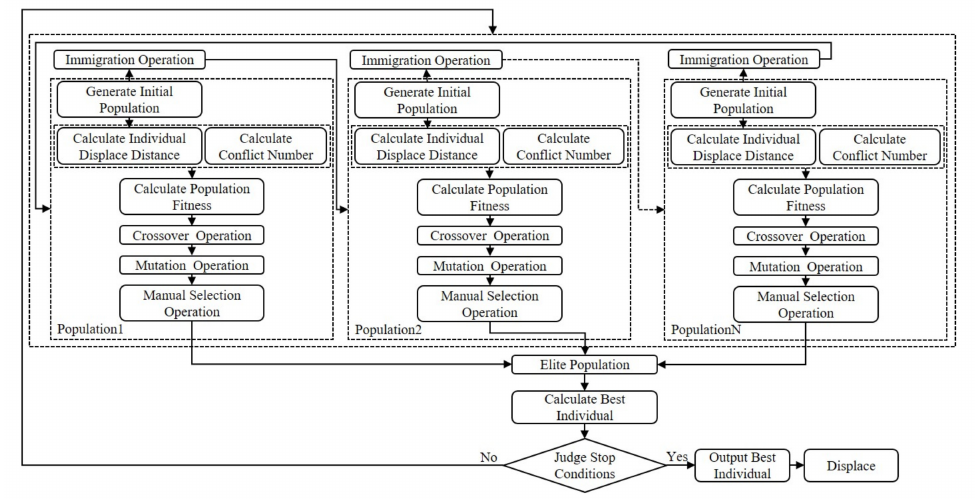
Figure 1. Framework of the BDMPGA.